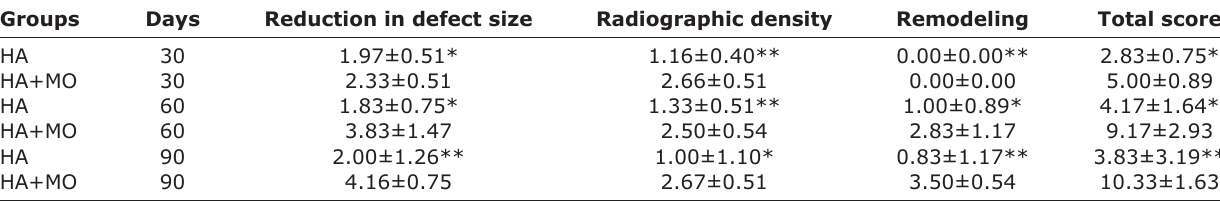
Table-2: Radiographic mean±SD scores of different parameters in groups (“HA” and “HA+BM”), and time periods (30, 60, and 90 days). Groups